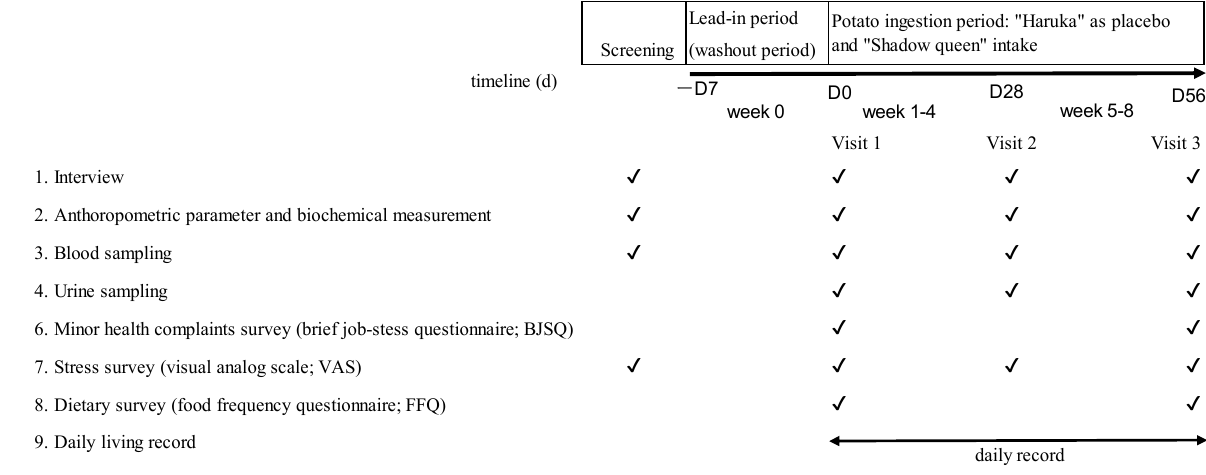
Figure 1. Schematic representation of the study/protocol.